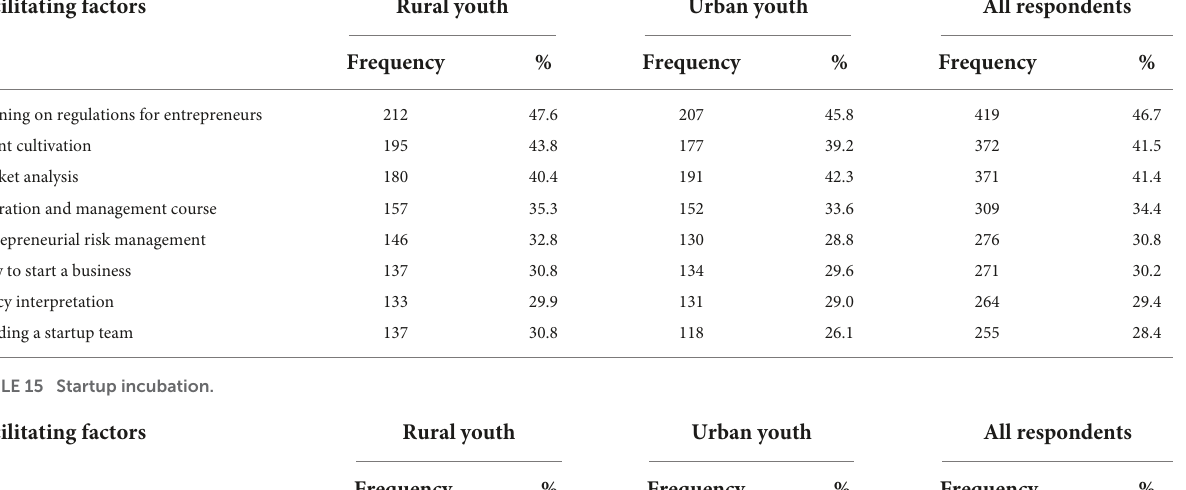
TABLE 14 Team formation and operations.